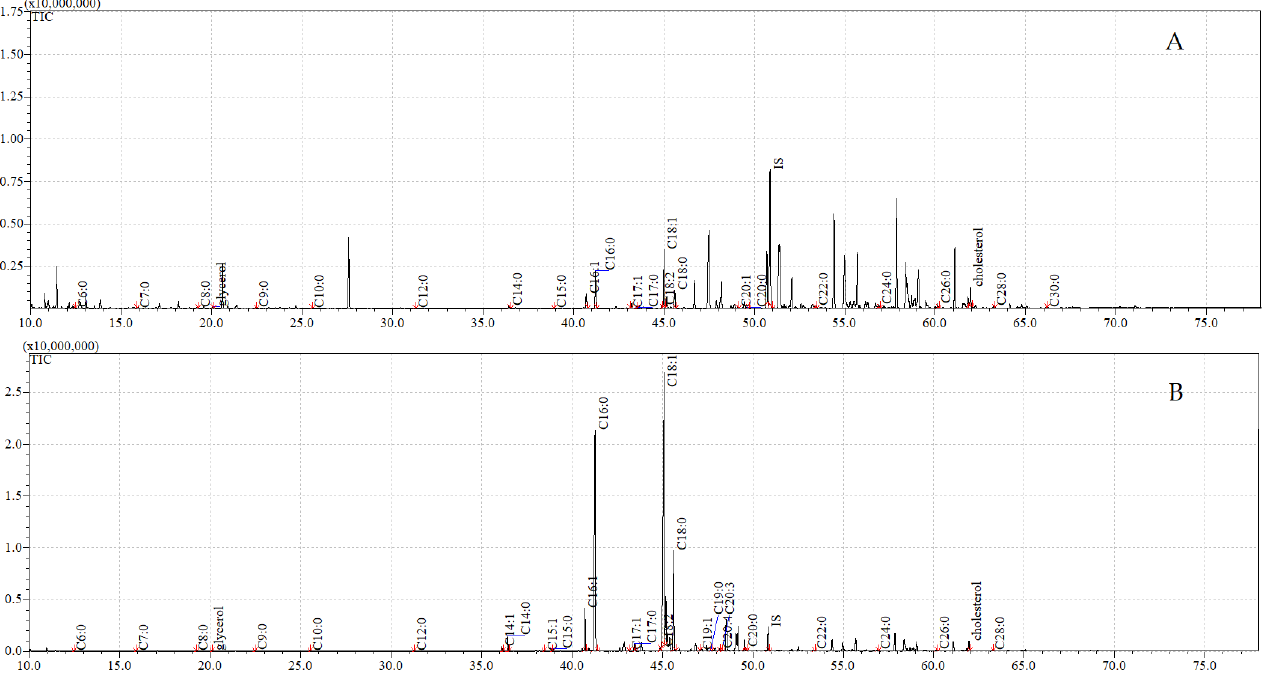
Figure 2. The total ion current (TIC) chromatogram of fatty acids (TMS esters) of the ether extract (extract I) from control (A) and after C. coronatus exposition (B) S. argyrostoma pupae . Internal standard (IS, 19-methylarachidic acid); the following fatty acids and molecular ions: hexanoic acid (C6:0, m/z = 188), heptanoic acid (C7:0, m/z = 202), octanoic acid (C8:0, m/z = 216), nonanoic acid (C9:0, m/z = 230), decanoic acid (C10:0, m/z = 244), dodecanoic acid (C12:0, m/z = 272), tetradecenoic acid (C14:1, m/z = 298), tetradecanoic acid (C14:0, m/z = 300), pentadecanoic acid (C15:0, m/z = 314), hexadecenoic acid (C16:1, m/z = 326), hexadecanoic acid (C16:0, m/z = 328), heptadecenoic acid (C17:1, m/z = 340), heptadecanoic acid (C17:0, m/z = 342), octadecadienic acid (C18:2, m/z = 352), octadecenoic acid (C18:1, m/z = 354), octadecanoic acid (C18:0, m/z = 356), nonadecanoic acid (C19:0, m/z = 370), eicosenoic acid (C20:1, m/z = 382), eicosanoic acid (C20:0, m/z = 384), docosanoic acid (C22:0, m/z = 412), etracosanoic acid (C24:0, m/z = 440), hexacosanoic acid (C26:0, m/z = 468), octacosanoic acid (C28:0, m/z = 496), triacontanoic acid (C30:0, m/z = 524).